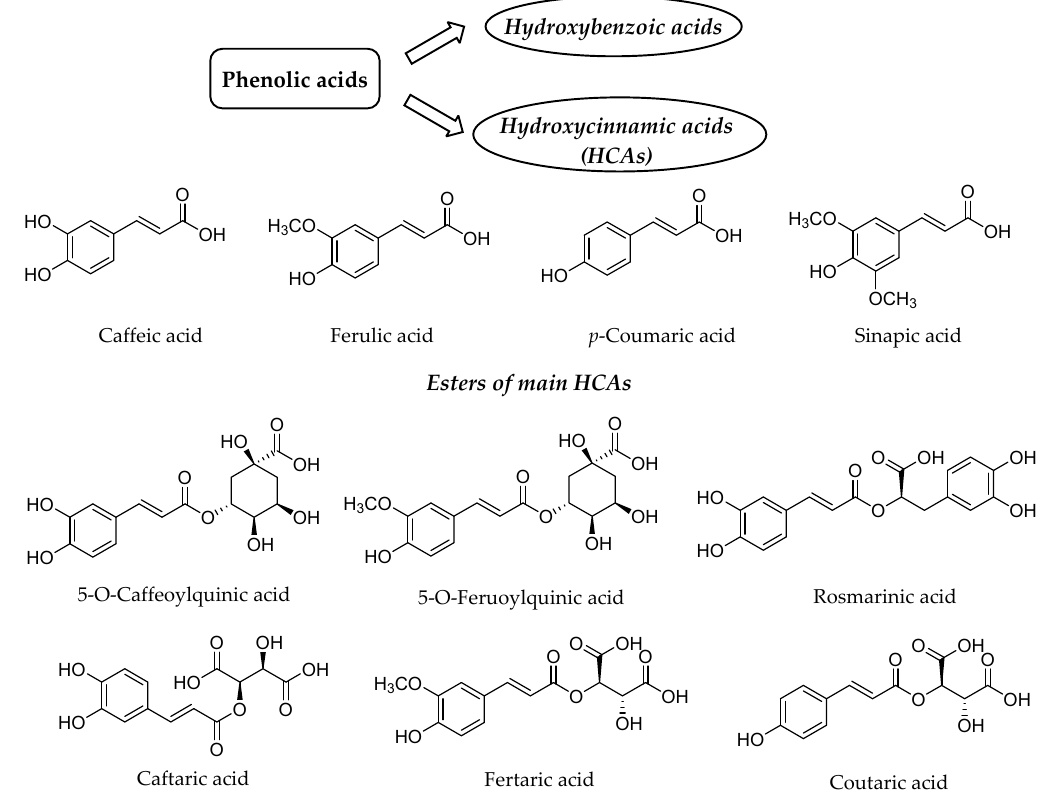
Figure 1. Structure of the main hydroxycinnamic acids (HCAs) and their esters as one of the major class of phenolic acids.